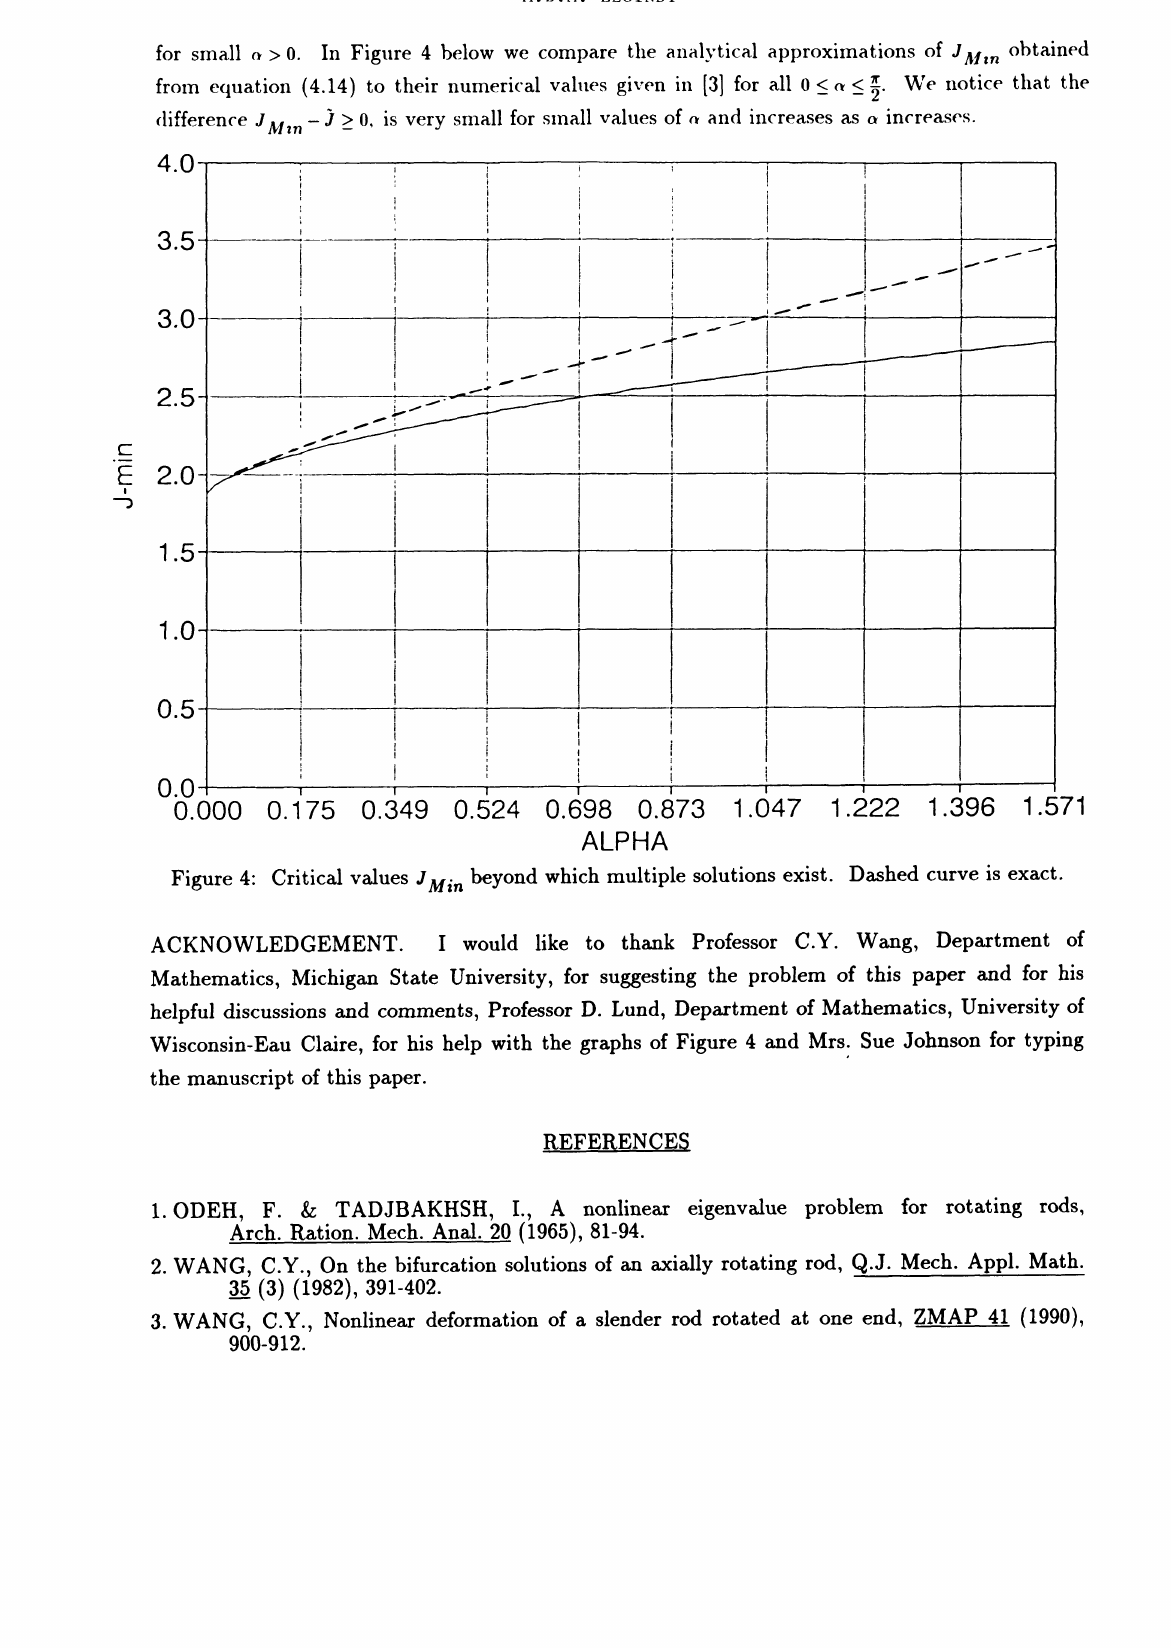
Figure 4: Critical values JMin beyond which multiple solutions exist. Dashed curve is